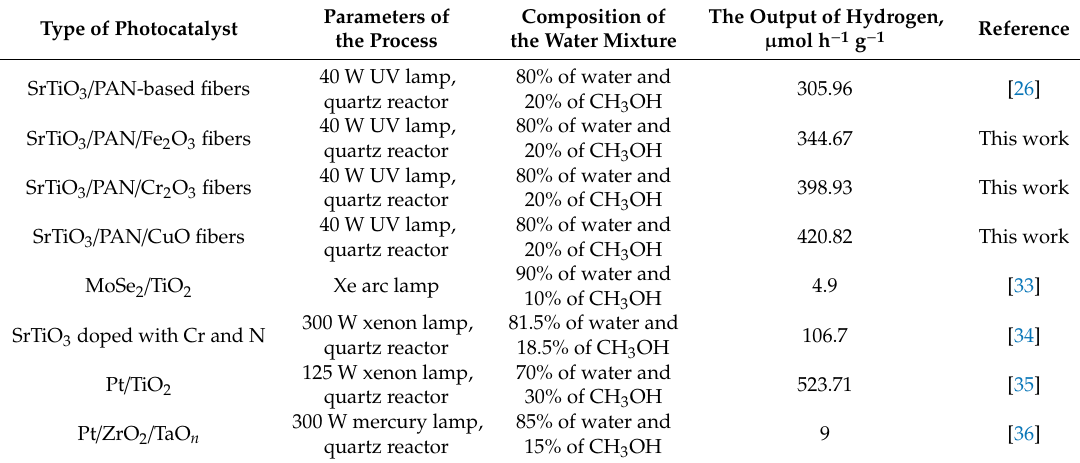
Table 1. Comparison of the photocatalytic activity of di ff erent photocatalysts for producing hydrogen by splitting mixtures of water and